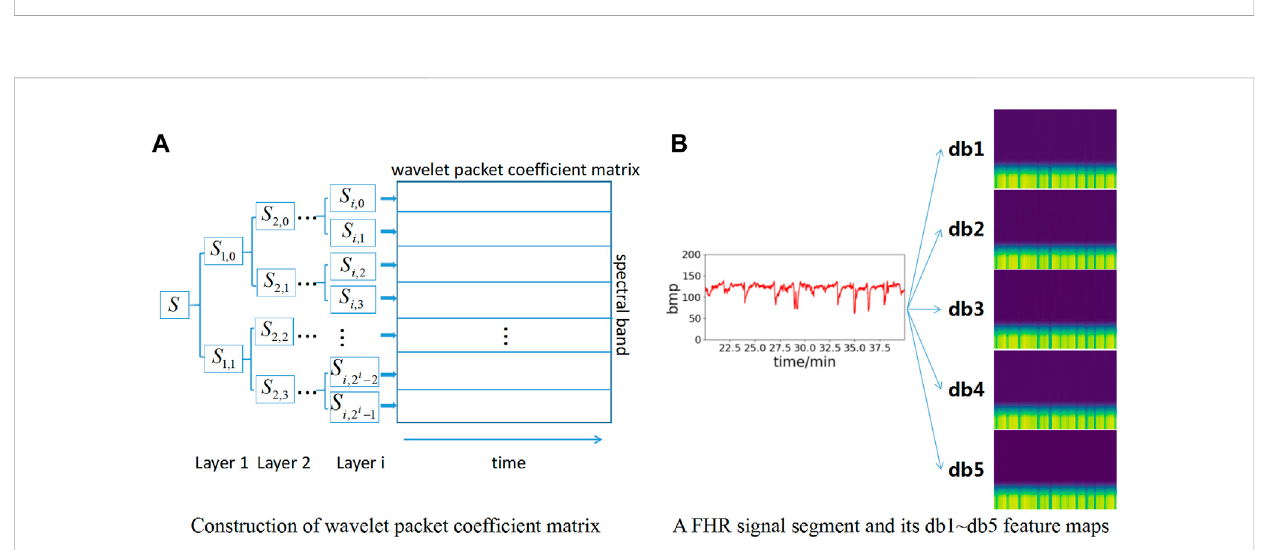
FIGURE 3 Constructionof feature mapsbased on wavelet packet coef fi cient matrix. (A) Construction ofwavelet packetcoef fi cient matrix; (B) Construction of db1~db5 feature